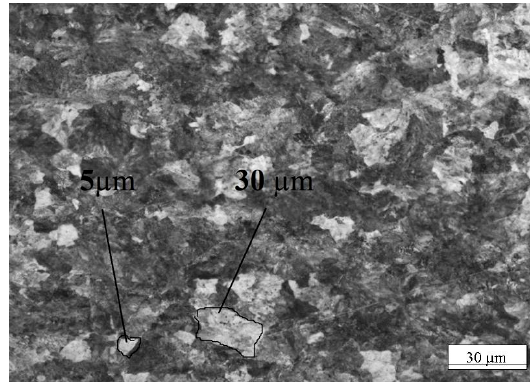
Figure 1. Typical microstructure of patenting wire, ×500.